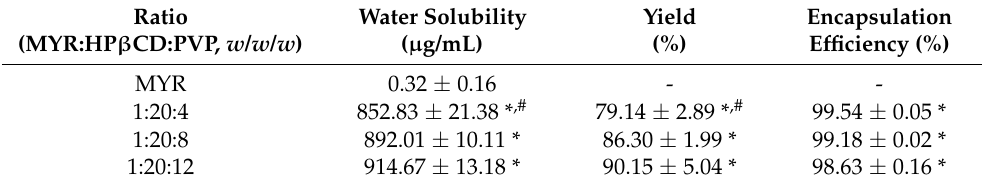
Table 1. The water solubility, yield, and encapsulation efficiency of